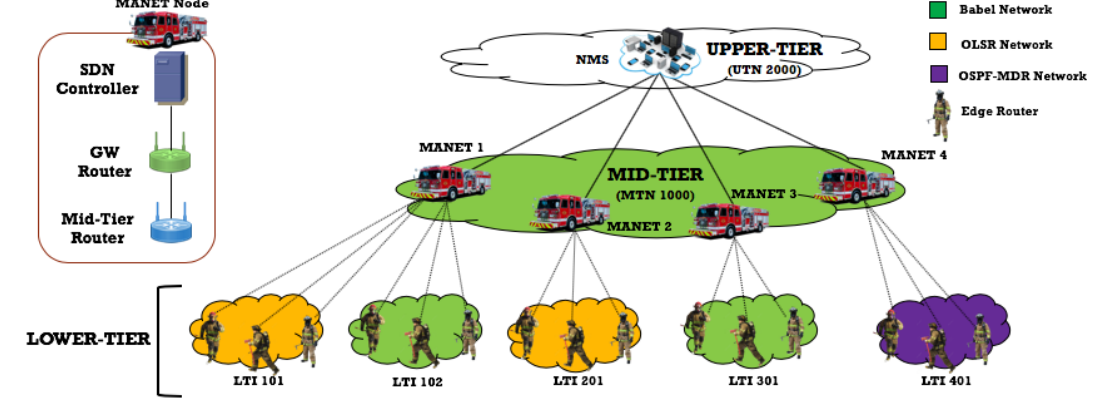
Figure 2. SDN Operational Overview (OV)